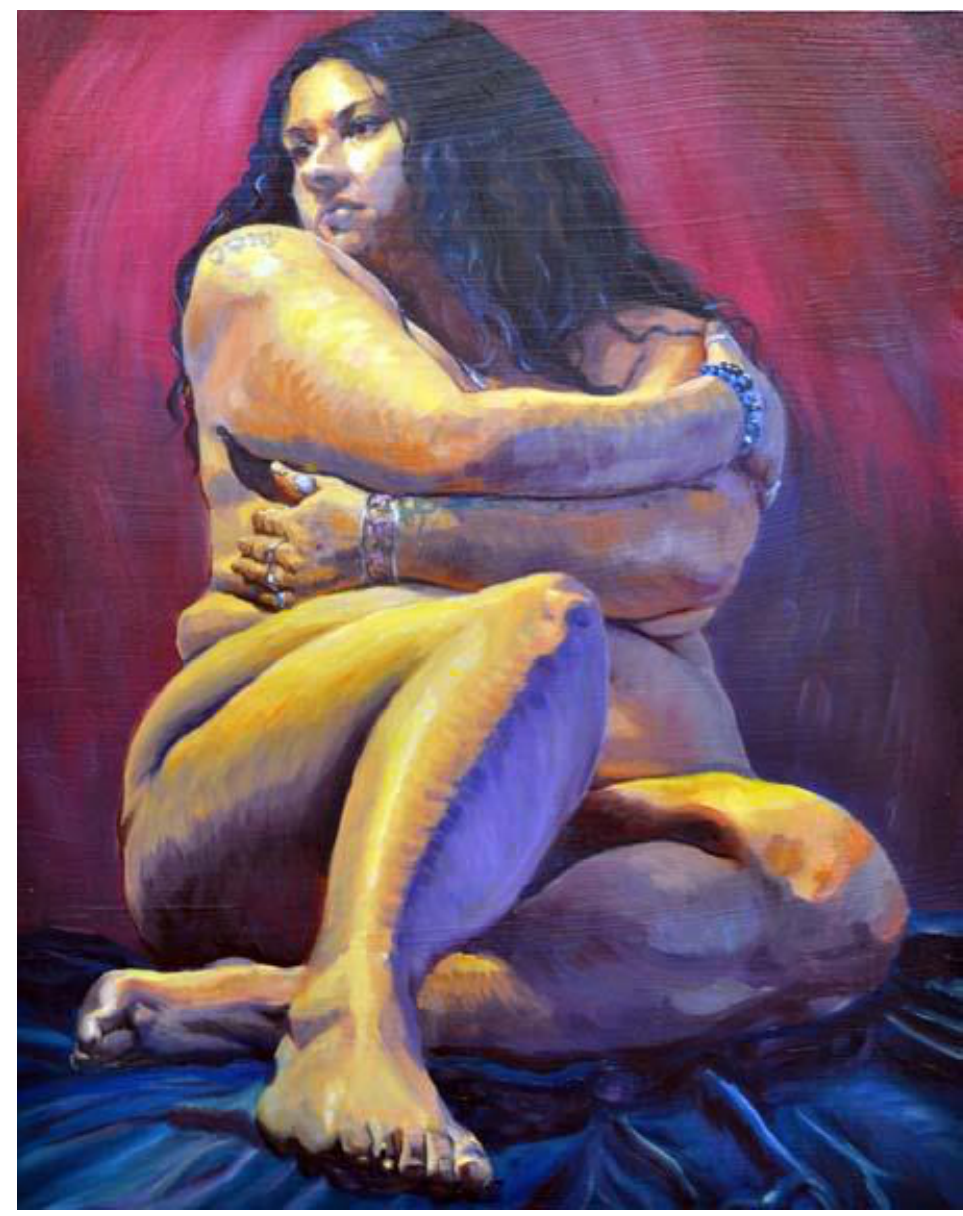
Figure 3 Cecelia Ivy Price, Coming to Confidence III, 2014, Oil on